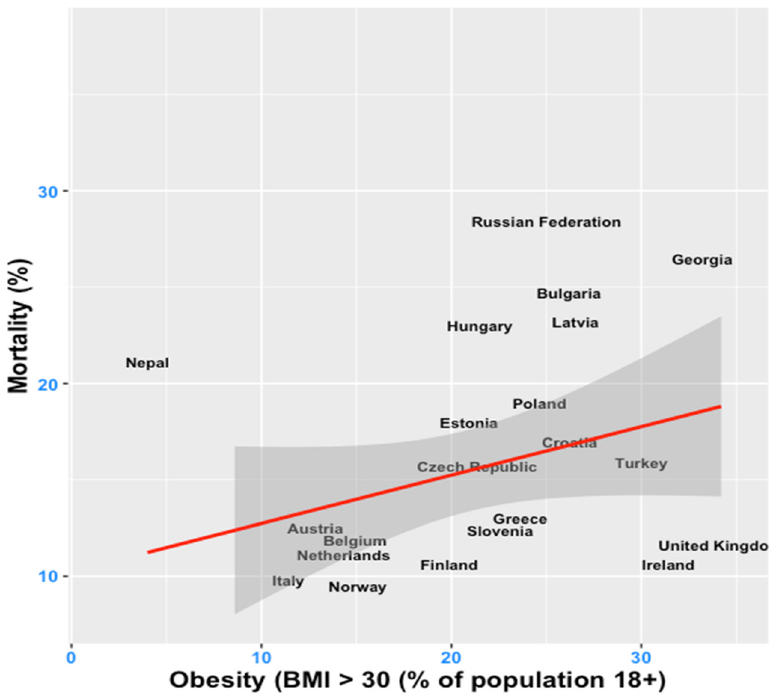
Figure 1. Obesity (percentage of population with a body mass index (BMI) > 30% in all adult pop- ulation) and mortality, most recent year of available data per country. The red line represents the fitted linear regression line, while the dark grey area displays the 95% confidence interval for pre- dictions from a linear model. Source of data: World Bank’s Development Indicators (WDI) data- base.